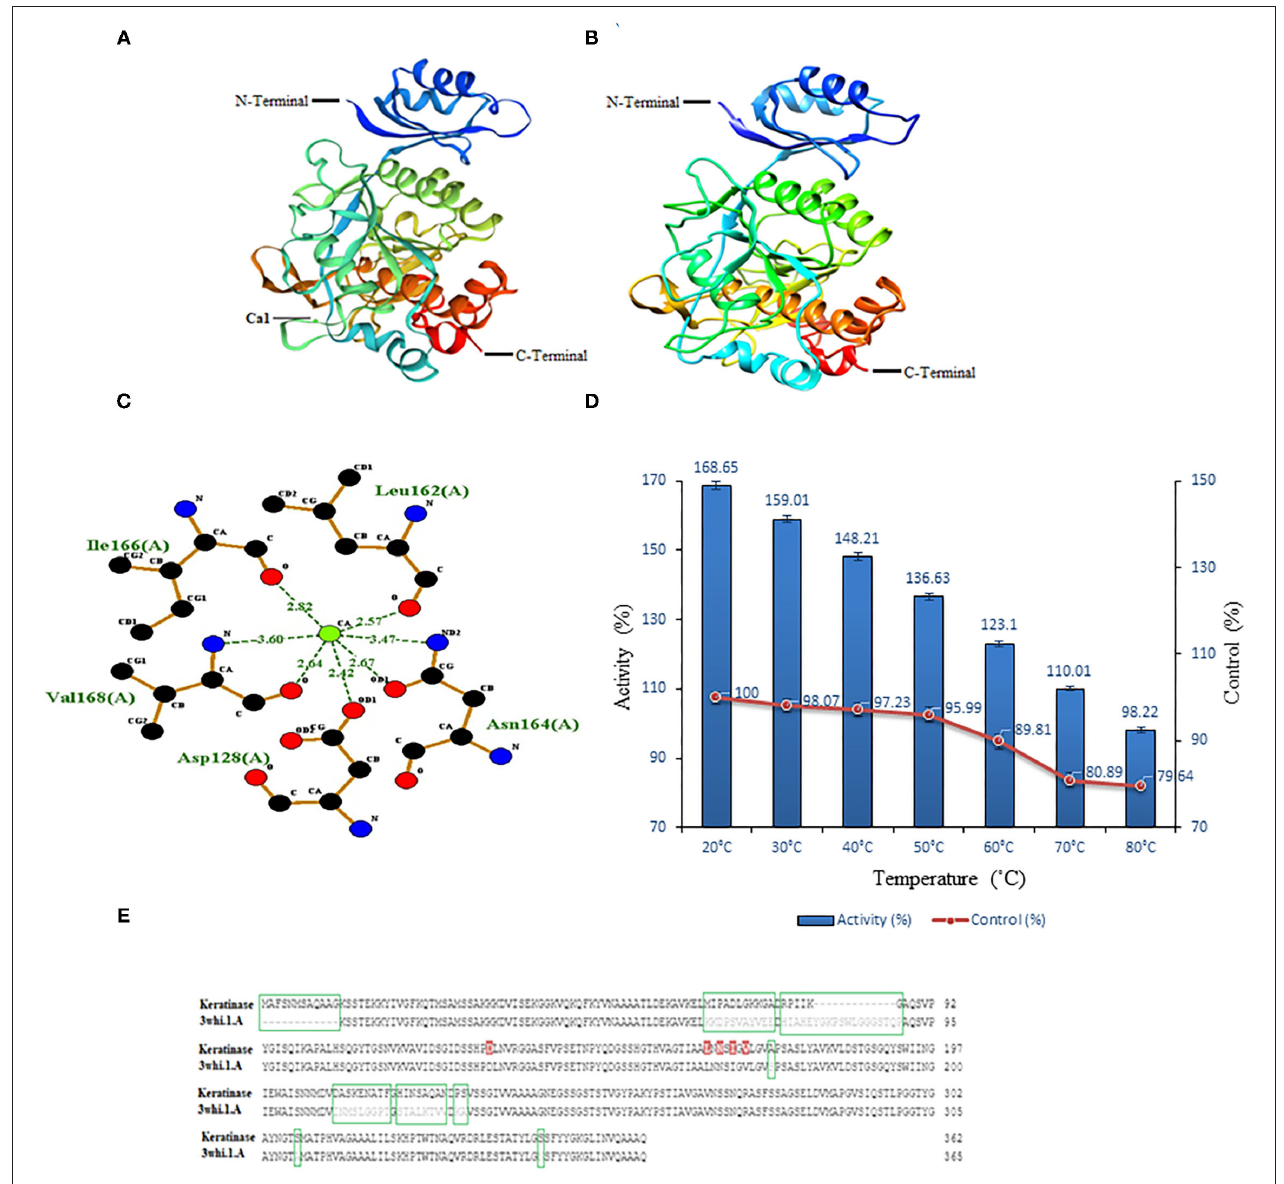
FIGURE 7 | Modeled structures of keratinase and model-template alignment. (A) 3D structure of keratinase modeled using Swiss-model. The green ball here represents calcium ions. (B) 3D structure of keratinase modeled using Phyre2. (C) In silico analysis of Ca1 binding site. Two-dimensional view of interactive residues of keratinase with Ca1 (Asp 128 , Leu 162 , Asn 164 , Ile 166 , and Val 168 ) along with the distance between target atom and Ca1. (D) In vitro effect of CaCl 2 (5mM) on keratinase activity at different temperatures (20–80 ◦ C). (E) Encircled (green) are missing/dissimilar residues of keratinase in comparison to template and red marked are the predicted Ca1-binding sites of